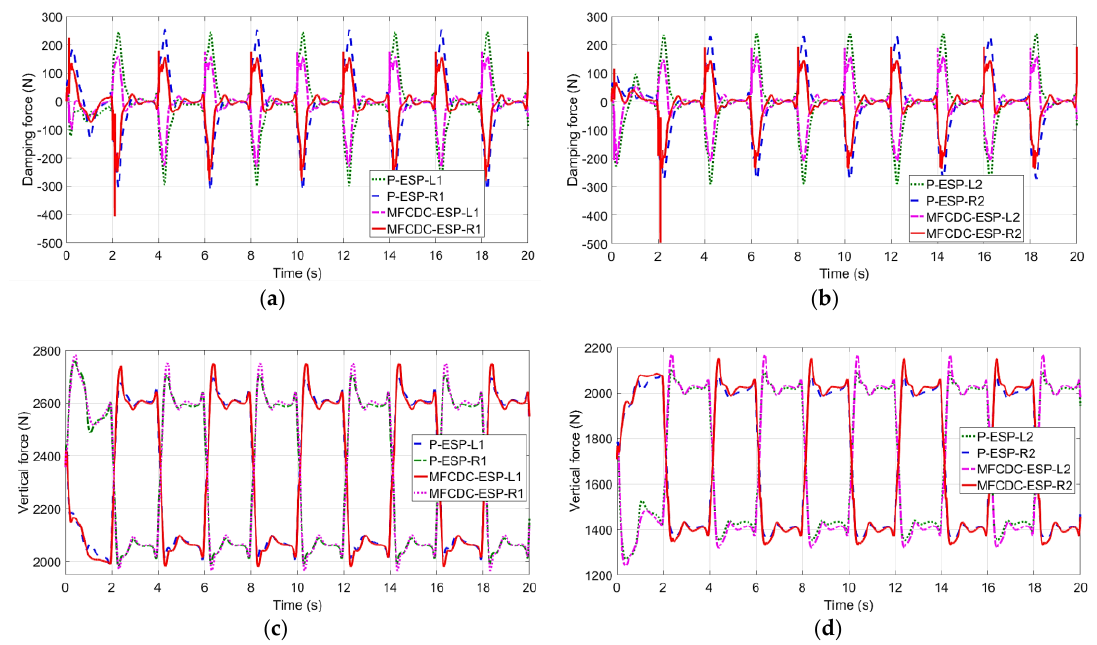
Figure 10. Damping forces and vertical forces of each wheel of the sine wave steer input test with P-ESP and MFCDC-ESP. The details are available in the legend. L denotes left, R denotes right, 1 denotes the front axle, and 2 denotes the rear axle. ( a ) is the comparison of the damping forces of the front wheels. ( b ) is the comparison of the damping forces of the rear wheels. ( c ) is the comparison of the vertical forces of the front wheels. ( d ) is the comparison of the vertical forces of the rear wheels. Table 8. Main comparison results for the sine wave steer input test (P-ESP, MFCDC-ESP). Test Results (Unit)